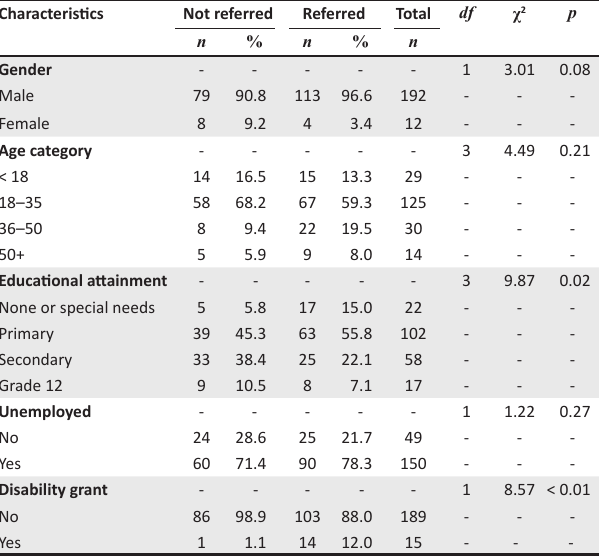
TABLE 2: Socio-demographic profile comparison between group referred to Fort Napier Hospital and group not referred. Characteristics